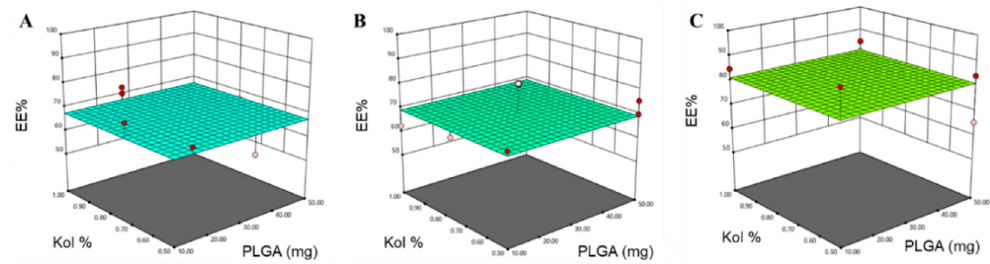
Figure 4. Response surface plots for the effect of the amount of PLGA (mg) and Kol % ( w / v ) on EE% using ( A ) PLGA-7K, ( B ) PLGA-24K and ( C ) PLGA-38K.